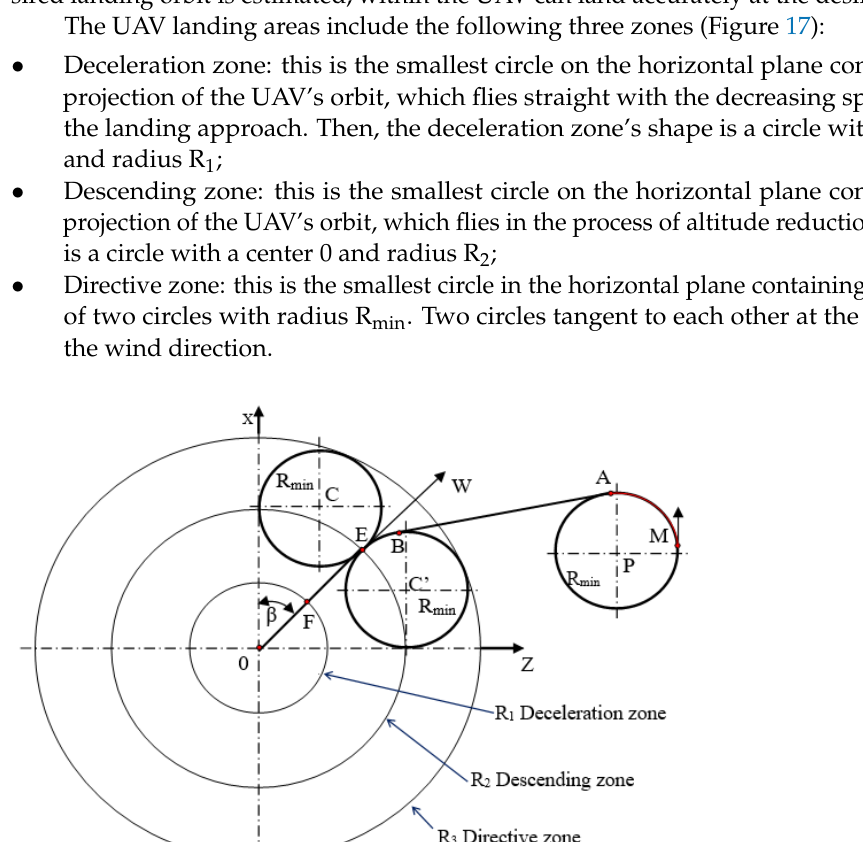
Figure 16. Obstacle representation and safe distance calculation.